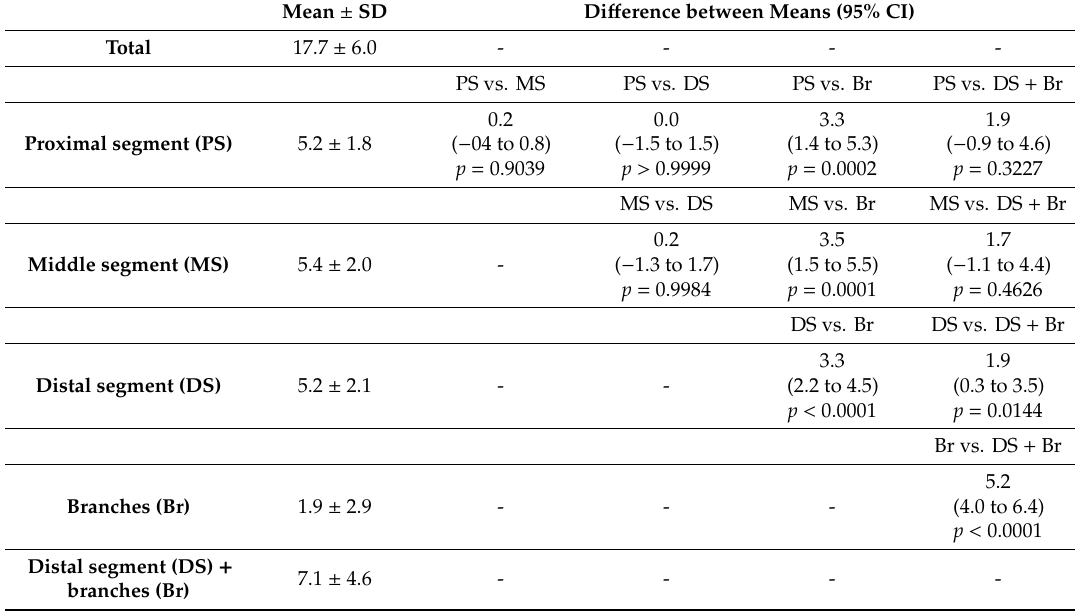
Table 2. Number of ablated spots in renal arteries (left + right) in 30 patients. Mean ± SD Di ff erence between Means (95%